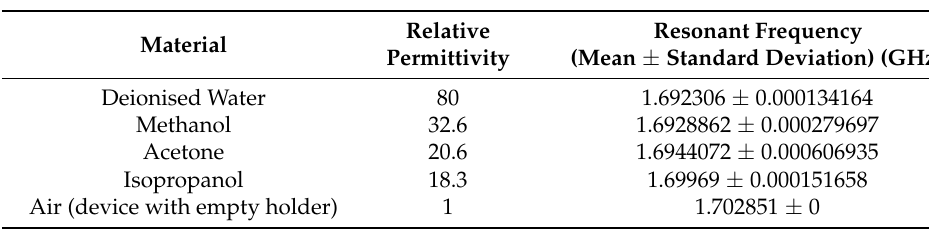
Table 1. Material properties and the mean value of the measured frequencies for solvents.